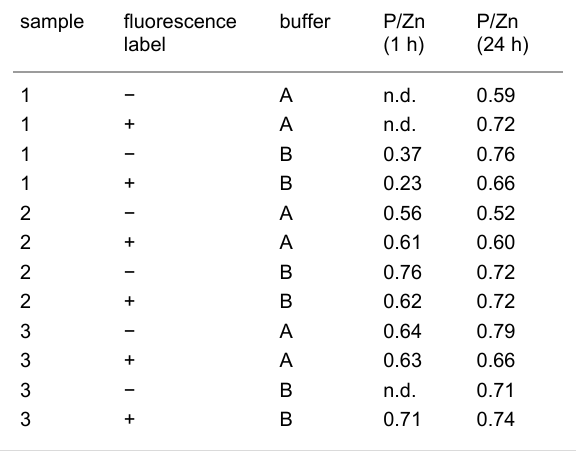
Table 1: Molar ratio P/Zn after one hour or one day of action by buffer solution at pH 7.0 on zinc oxide nanoparticles („+“: with